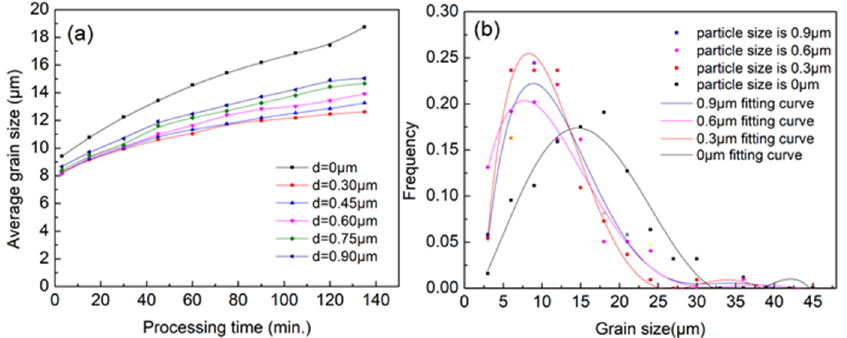
Figure 6. ( a ) The average grain size evolution at 573 K with second phase particles of different size; and ( b ) the distribution of grain size with processing 60